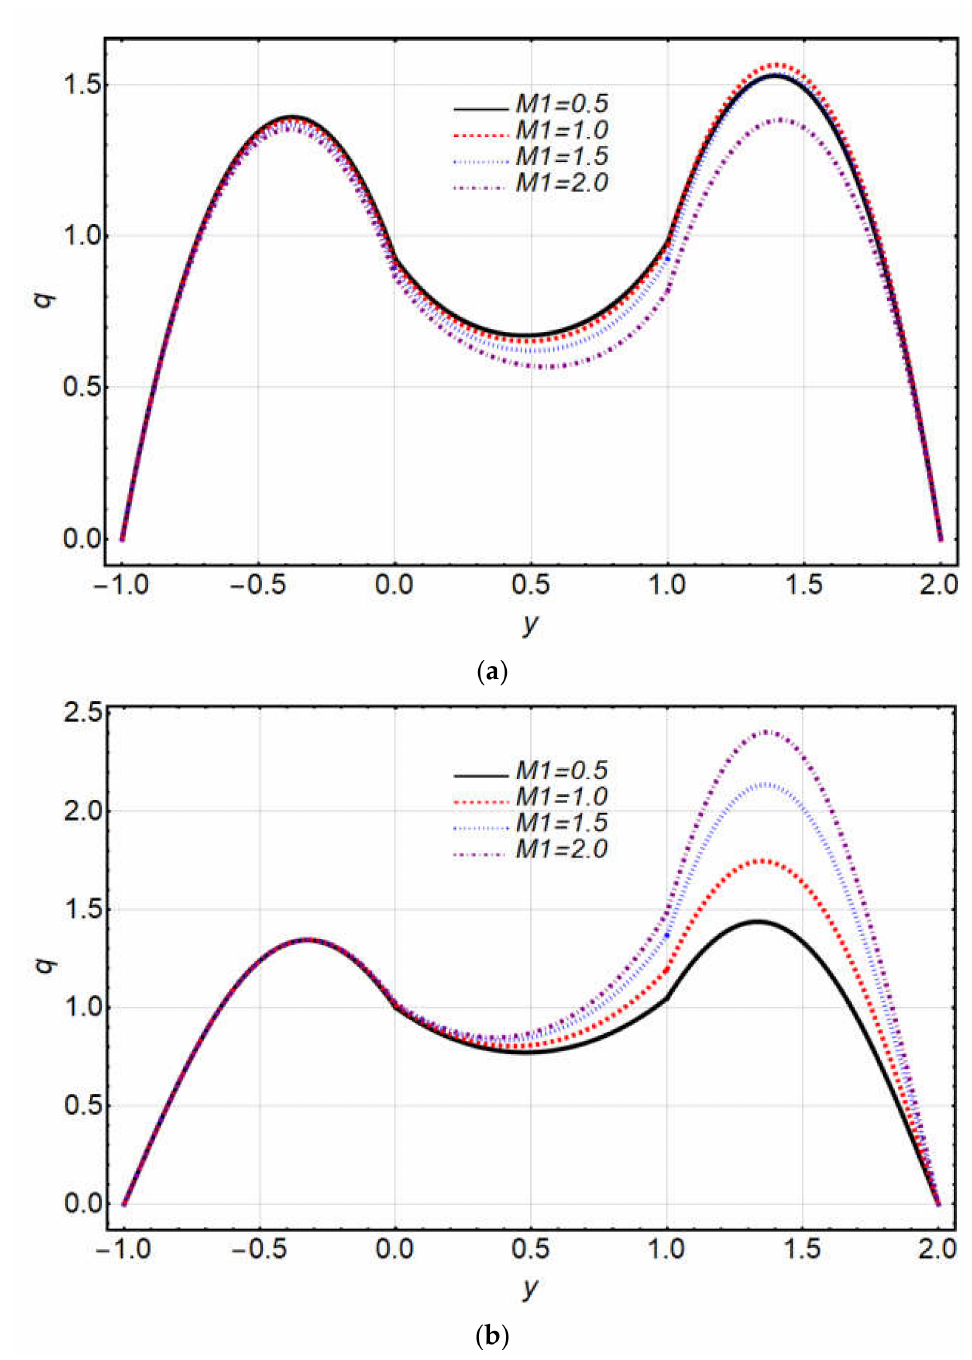
Figure 9. Velocity distribution of M 1 : ( a ) axial, ( b )